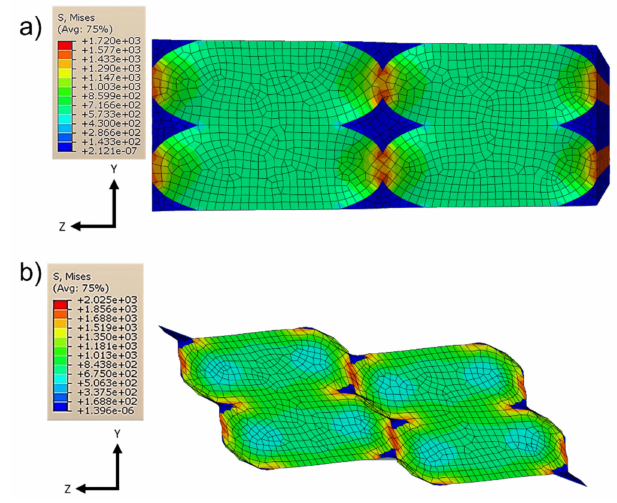
Figure 17. Von Mises stresses for G 13 ( a ) and G 23 ( b ).